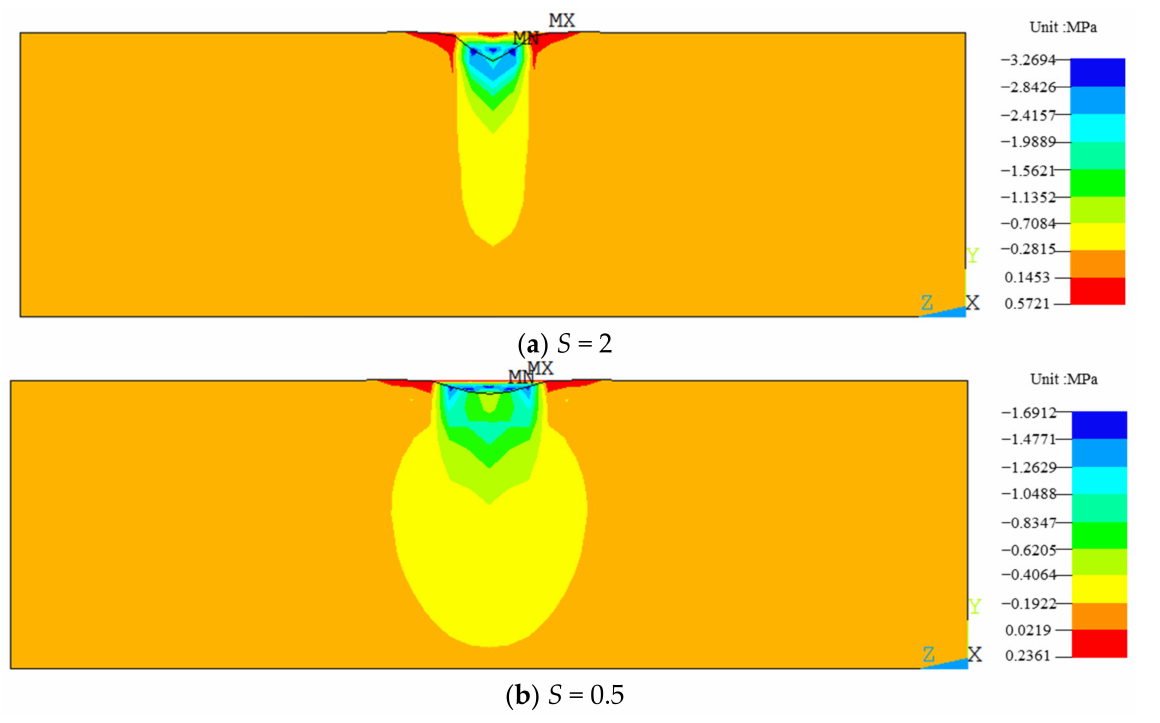
Figure 12. Impact stress in the sand cushion corresponding to falling stones of different shapes in numerical simulation. ( a ) and ( b ) represent rockfall with shape coefficients of 2 and 0.5,